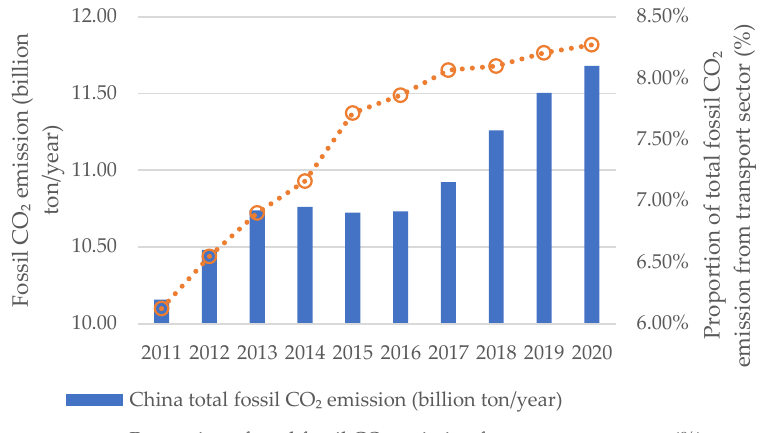
Figure 2. The curve of the proportion of fossil CO 2 emission from the transport sector and total fossil CO 2 emission in China from 2011 to 2020. Data source: EDGARv6.0 FT2020 fossil CO 2 GHG booklet2021. https://edgar.jrc.ec.europa.eu/report_2021#emissions_table (accessed on 19 December 2021).